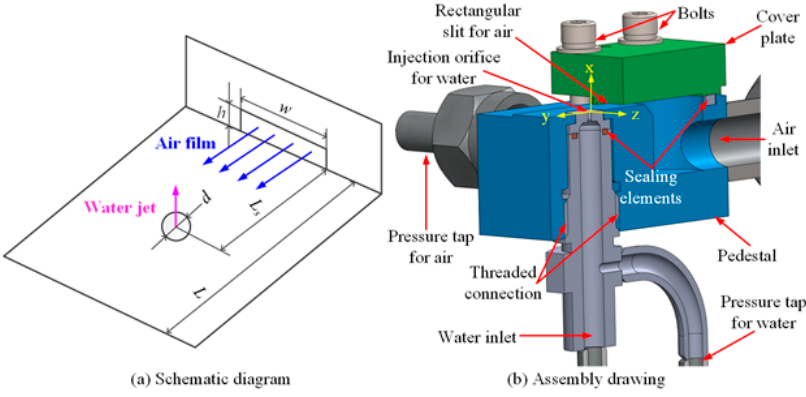
Figure 2. Structure of the gas–liquid pintle injection element [20].